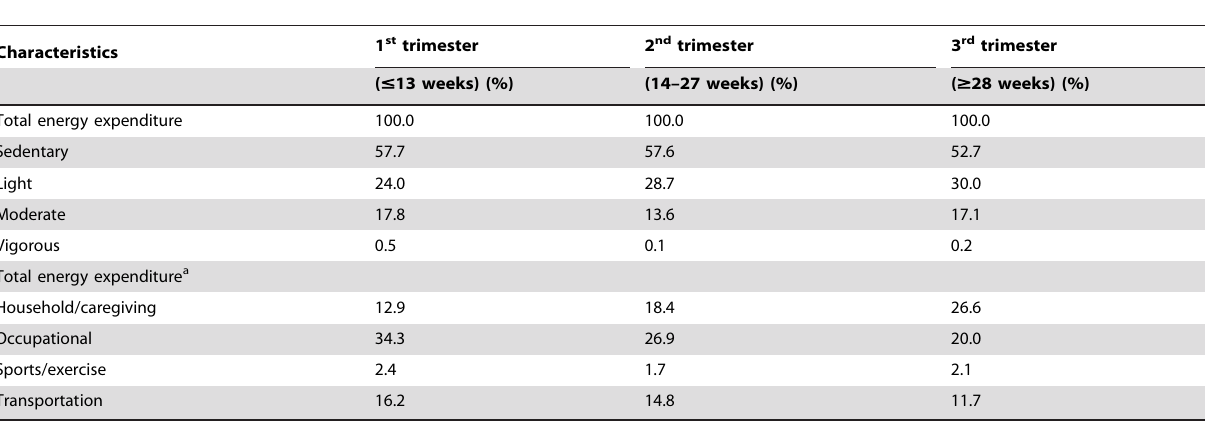
Table 4. Contribution of each type of activity to the total expenditure across different trimesters.